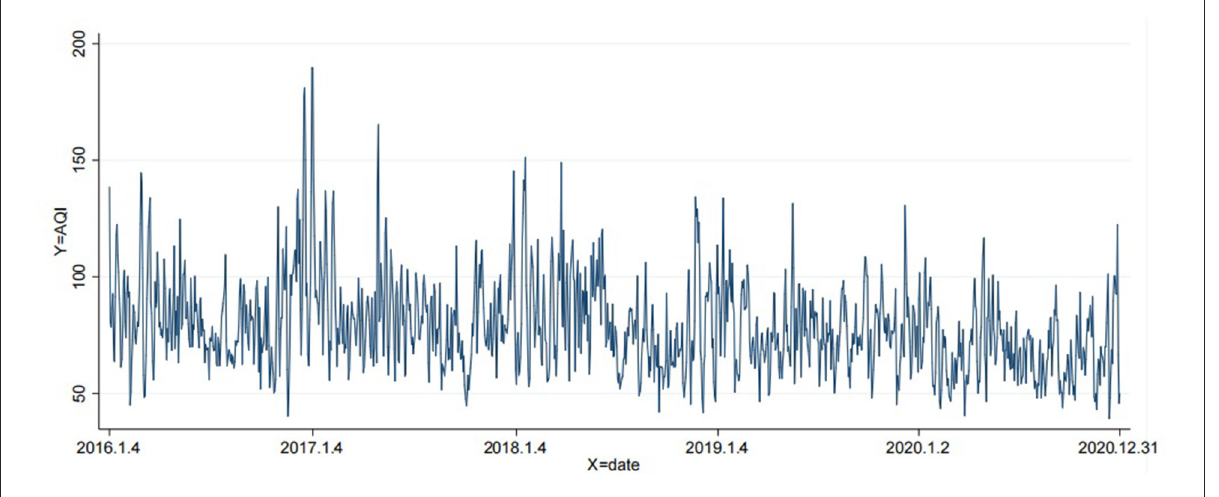
FIGURE2 Air pollution trends from 2016 to 2020.